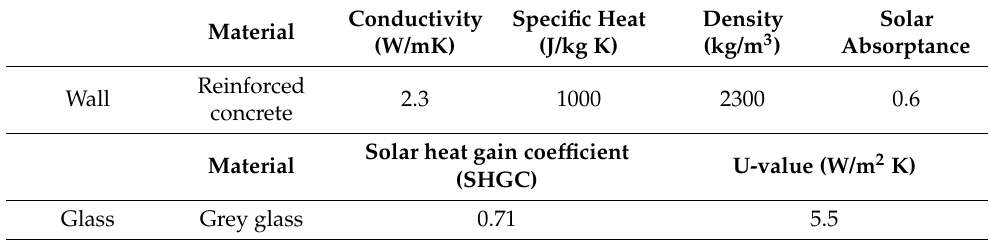
Table 4. Thermal and radiation properties of façade